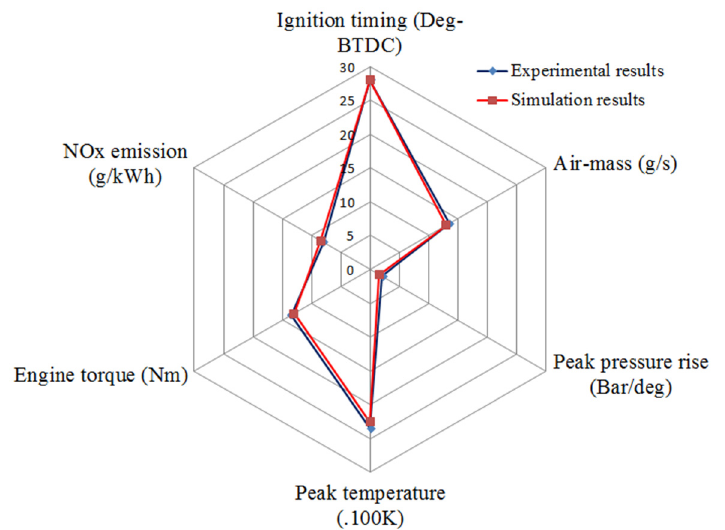
Figure 3. Model validation. Figure 3 represents the ignition timing in both cases for 3000 rpm engine